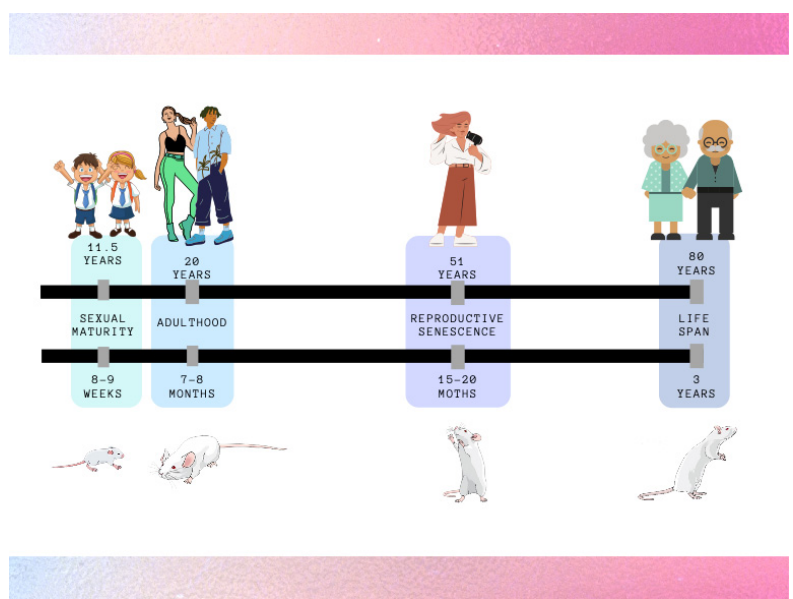
Figure 2. Comparative timelines between human and rat.